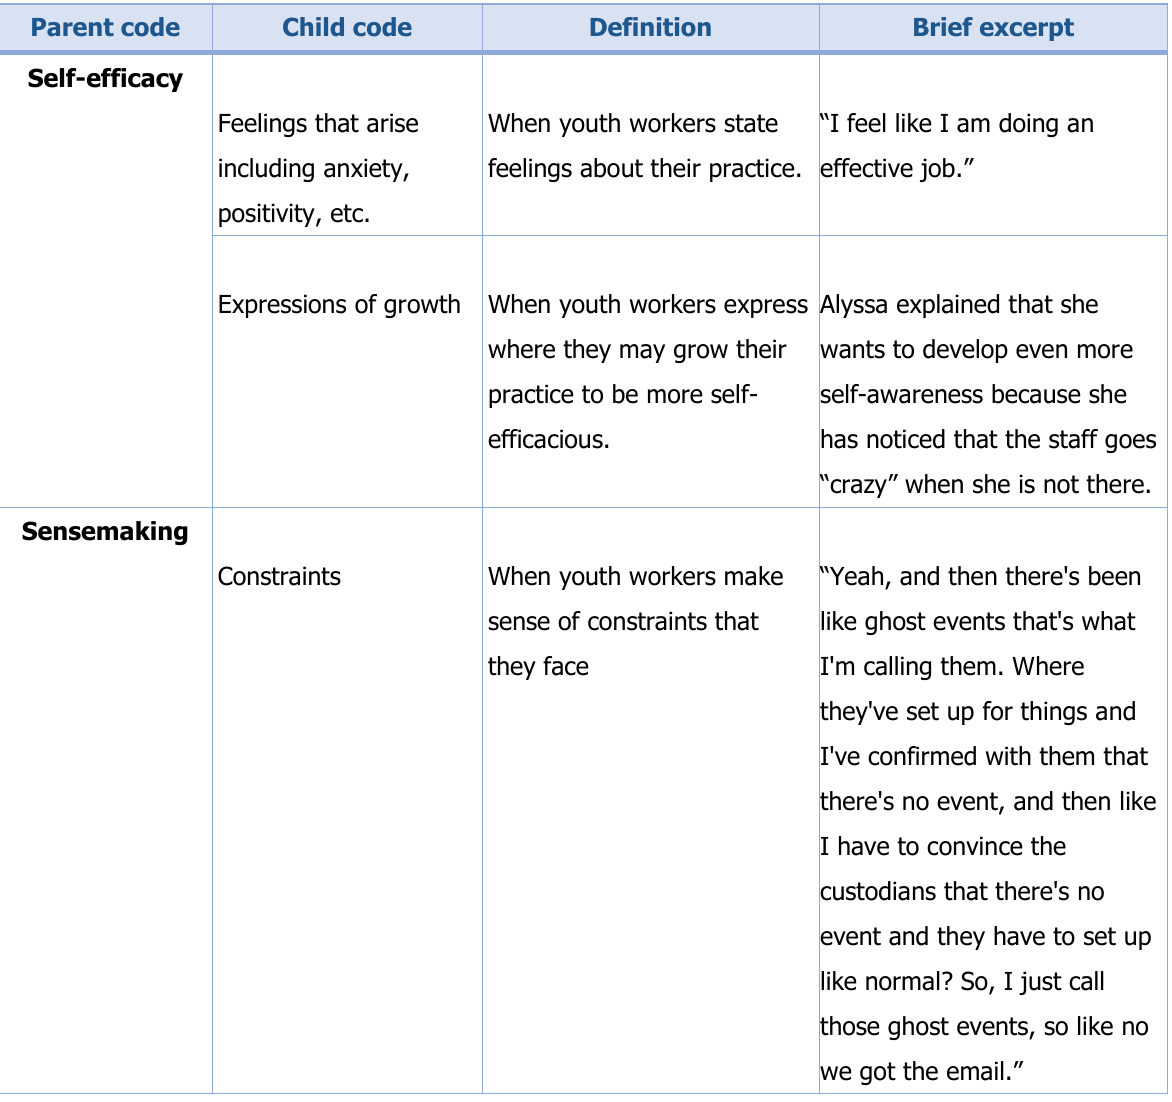
Table 2. Excerpt From